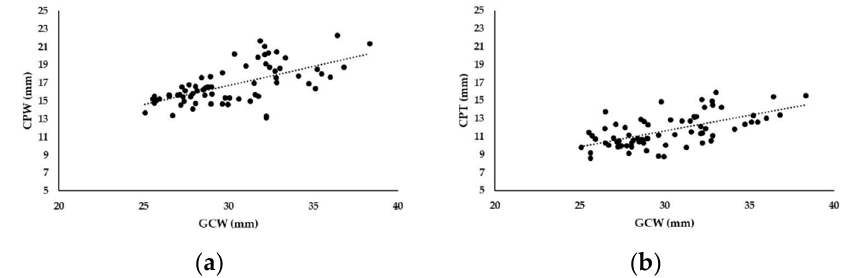
Figure 3. Correlation between the glenoid cavity width (GCW) and the width of the coracoid process (CPW) ( a ). Correlation between the glenoid cavity width (GCW) and the native thickness of the coracoid process (CPT) ( b ).